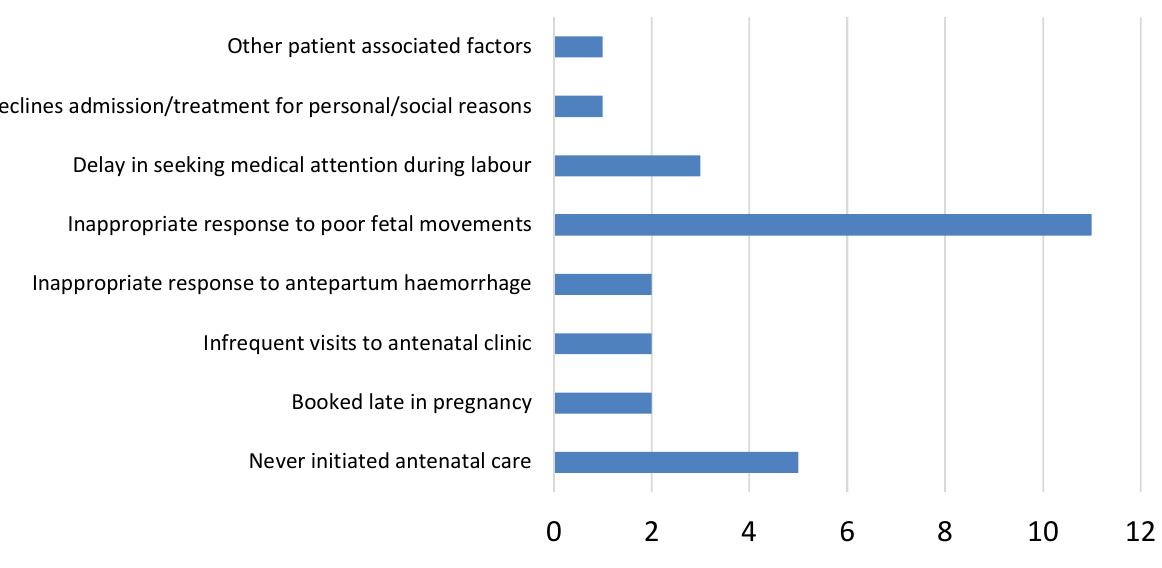
Figure 1: Patient-associated modifiable factors identified during the stillbirth